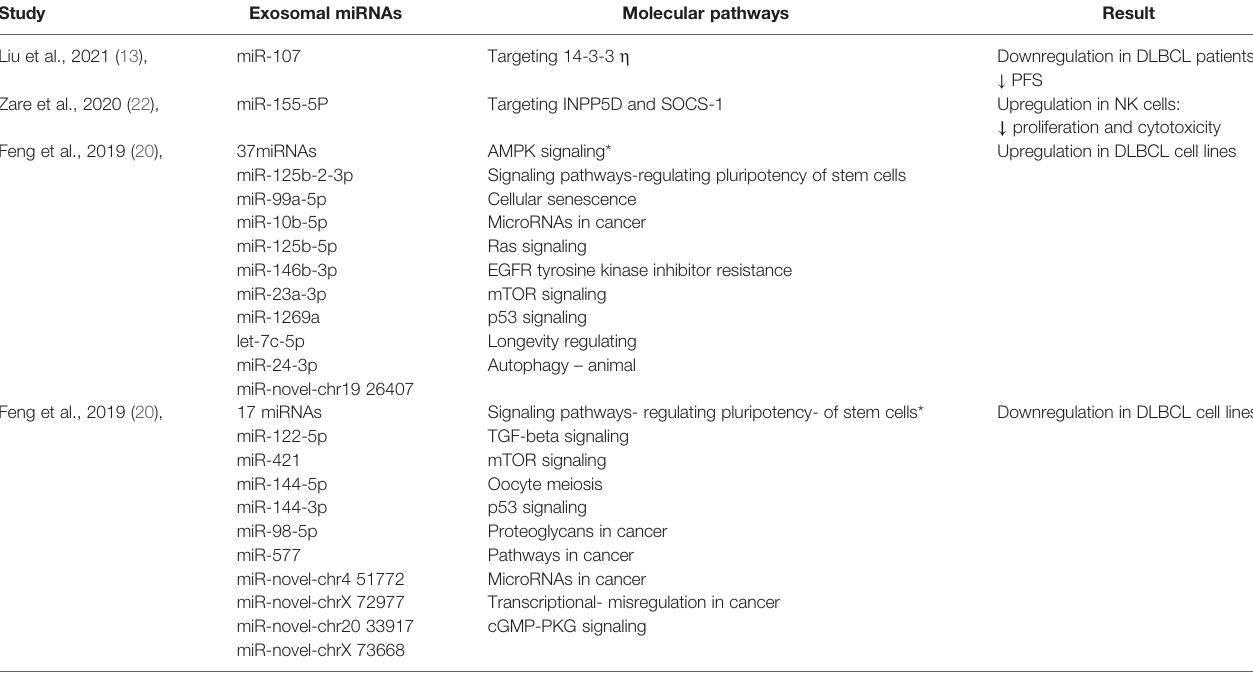
TABLE 7 | Molecular pathways associated with exosomal miRNAs in